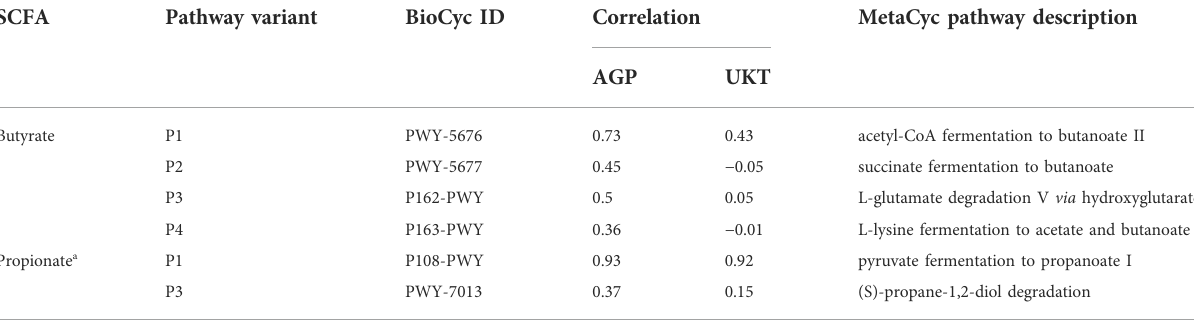
TABLE4Correlationcoef fi cientsbetweenphenotypeabundancesproducedbythePICRUSt2pipelinewithbinaryphenotypesandMetaCycpathway abundancess in AGP and UKT datasets.